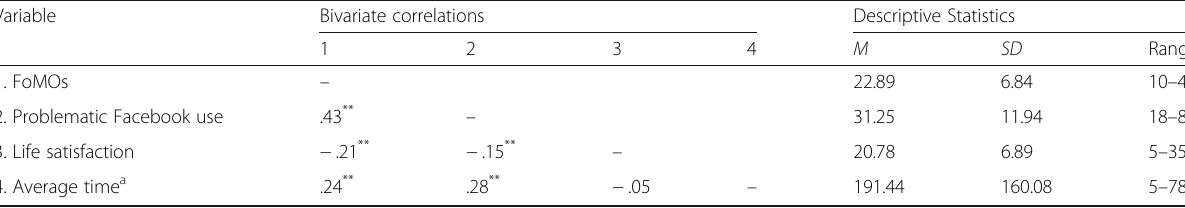
Table 2 Correlations and descriptive statistics of the study variables Variable Bivariate